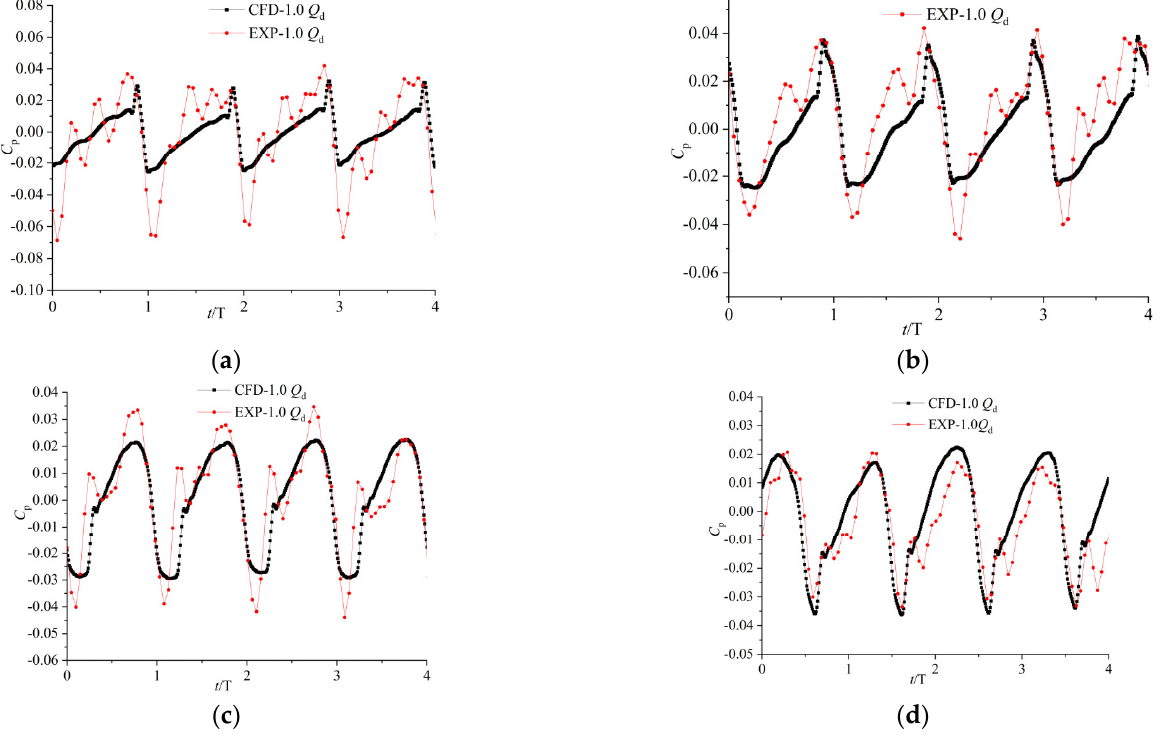
Figure 6. Comparison of pressure distribution at design flowrate. ( a ) Monitoring point V1. ( b ) Monitoring point V2. ( c ) Monitoring point V3. ( d ) Monitoring point V4.